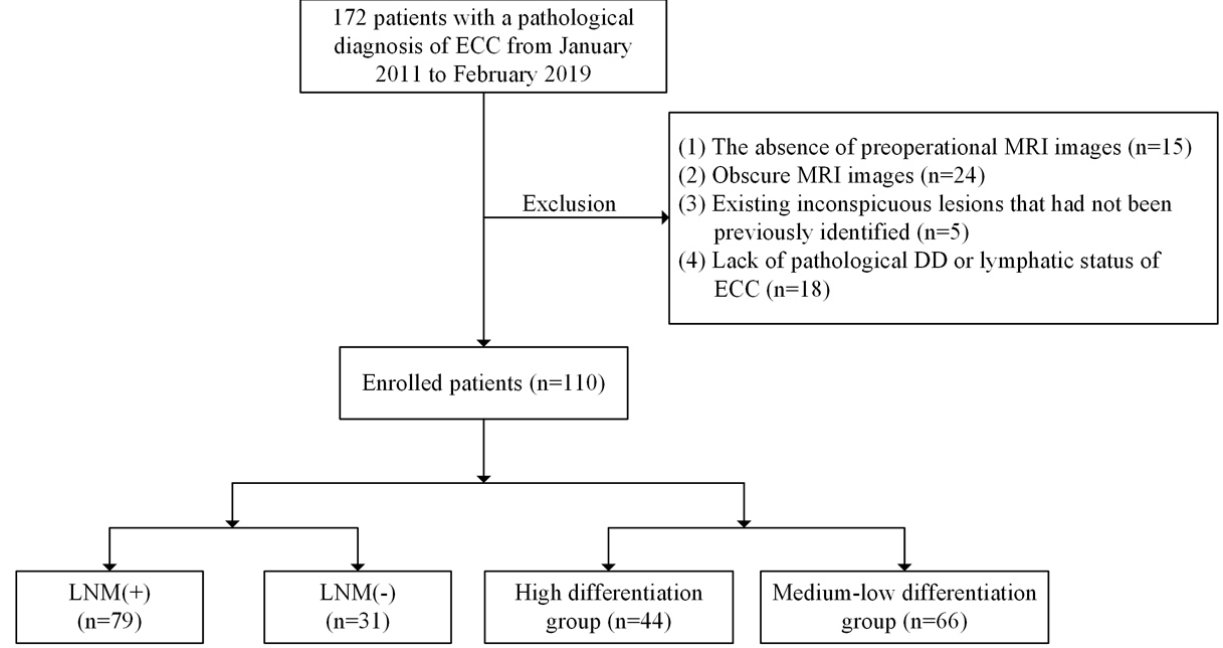
Figure 1. Flow diagram of patient cohort selection (n=110). DD: differentiation degree; ECC: extrahepatic cholangiocarcinoma; LNM: lymph node metastases; MRI: magnetic resonance